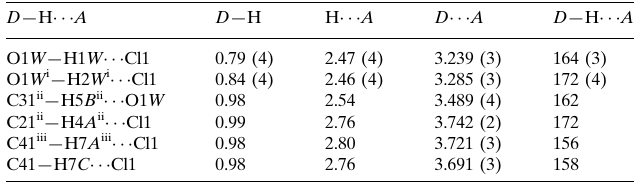
Hydrogen-bond geometry (A˚ , (cid:3)